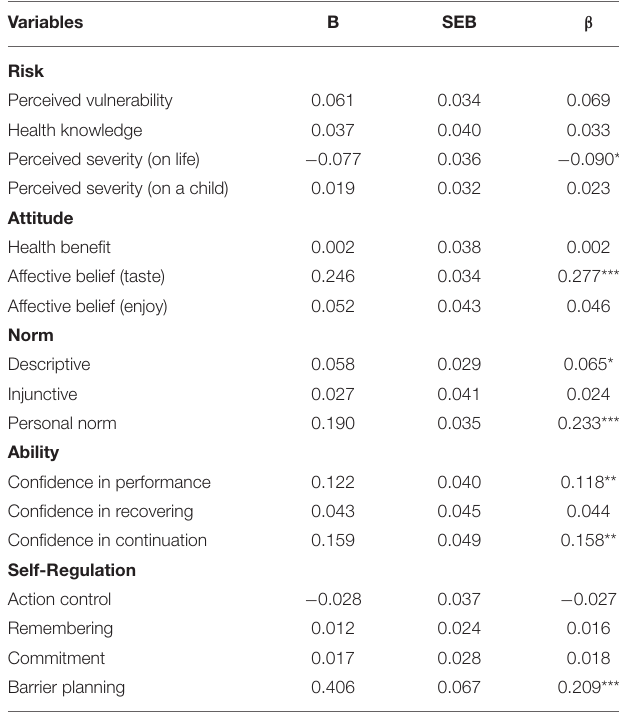
TABLE 2 | Regression analysis of all RANAS sub-factors psychological factors on HWT